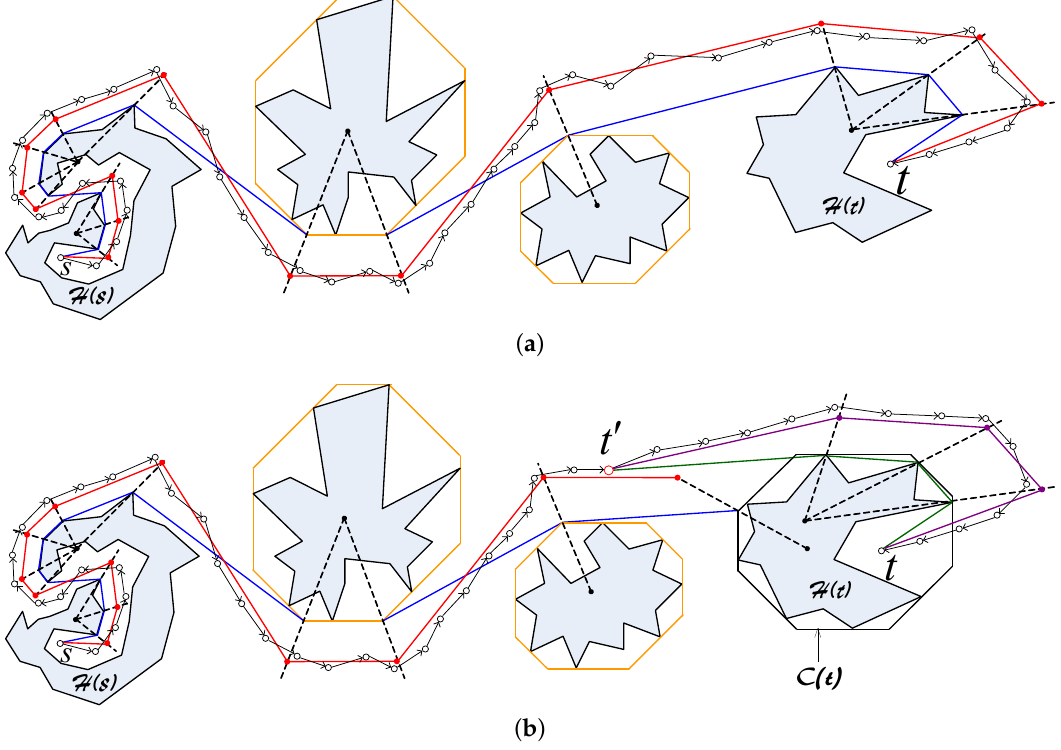
Figure 2. Data forwarding. The blue/green lines are the base path/sub-base path, the red/orange paths are the Euclidean routing path/sub-Euclidean routing path. The orange polygons are the items of C ( s , t ) . ( a ) Case 1: s is a t -aware node; ( b ) Case 2: s is a t -blind node. Otherwise, if s is a t -blind node (Figure 2b) (i.e., s does not have full information of the